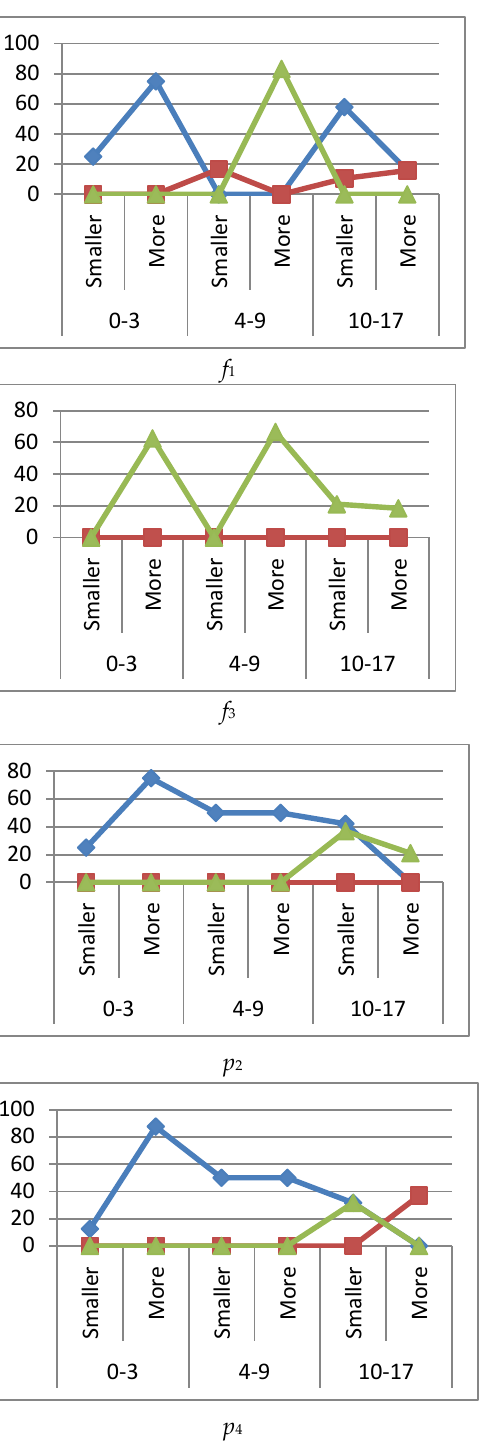
* The arrows in the table header show the deviation in the immunoglobulins to the smaller ↓ or more ↑ region relative to the reference interval. Figure 3 shows graphs of the percentage deviations in the immunograms for the Figure 3 shows graphs of the percentage deviations in the immunograms for the im- immune system state k 3 when immunoglobulins IgA, IgM are increased (more) or de- mune system state k 2 when immunoglobulins IgA, IgM are increased (more) or creased (smaller). decreased (smaller).